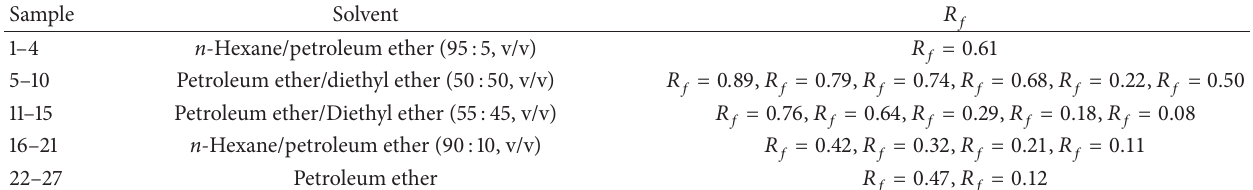
Table 1: Comparison 𝑅 𝑓 of some base colors in the walnut dye.